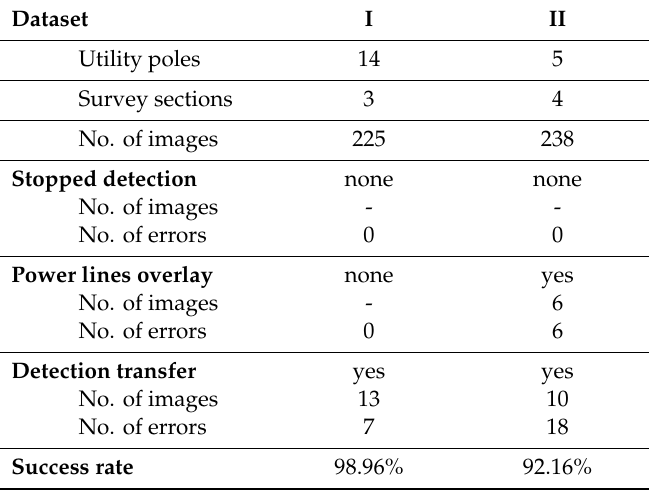
( c ) Figure 17. Example problematic images: ( a ) closely recorded wires; ( b , c ), two wires recorded as one line.